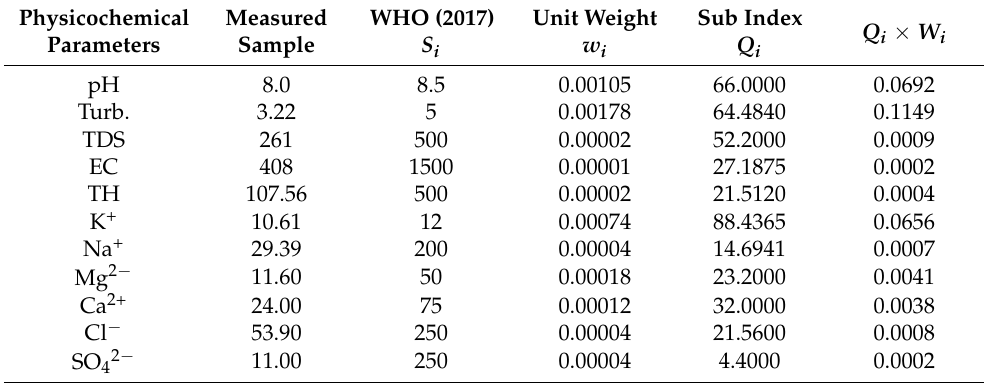
Table 1. Calculation of the DWQI based on the arithmetic weight method for physicochemical